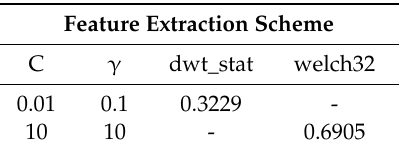
Table 17. Accuracy of test data classification for the SVM-RBF classifier for 10-fold cross-validation performed for the best and worst results obtained from the training / validation / test scheme.